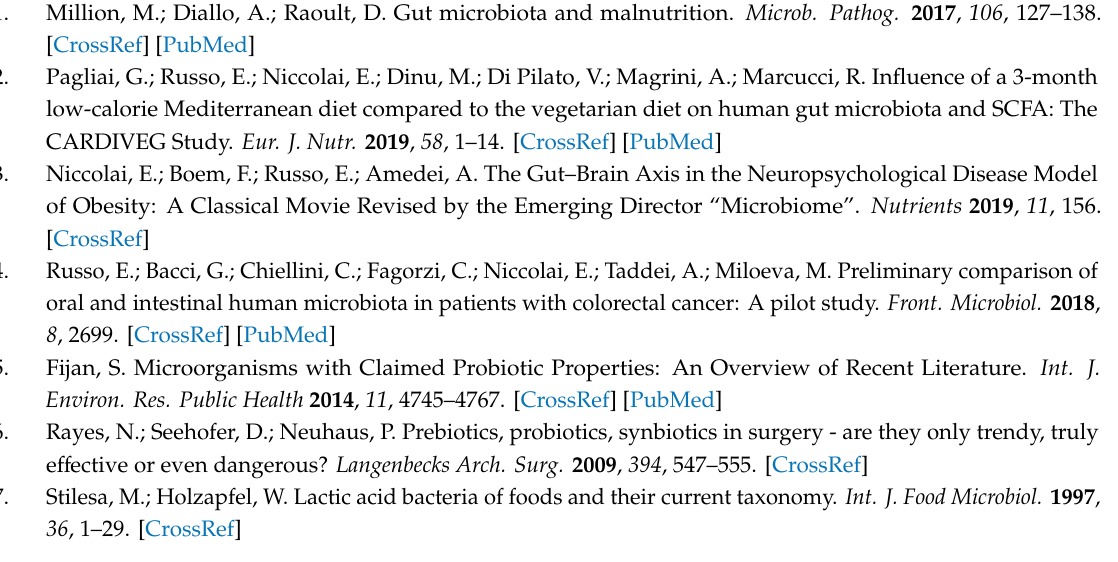
Figure S1: Electrophoresis gel: samples (1–5), negative control (NC). Bands are in accordance with the presence of the amplified DNA; Figure S2: The typical bacterial growth curve: Log X, Log X 0 , t and t 0 mark location of the values for the bacterial growth parameters; t k —the time of the experiment, t e —the time of exponential phase; L is the time of lag phase; Figure S3: LAB cultivation (24 h) under the influence of H 2 S. After 24 h the optical density (OD) was determined and, consequently, the reacting mixture was diluted and spread on the MRS agar; Figure S4: The calibration curves used for the conversion of CFU to OD; Table S1: Optical density data measured by Bioscreen C spectrophotometer (M ± S E , n = 5); Table S2: The conversion of OD to CFU used to create the calibration curves for Lactobacillus species; Table S3: CFU values calculated by calibration curves equations (M ± S E , n = 5); Table S4: The minimal inhibitory concentrations for Lactobacillus